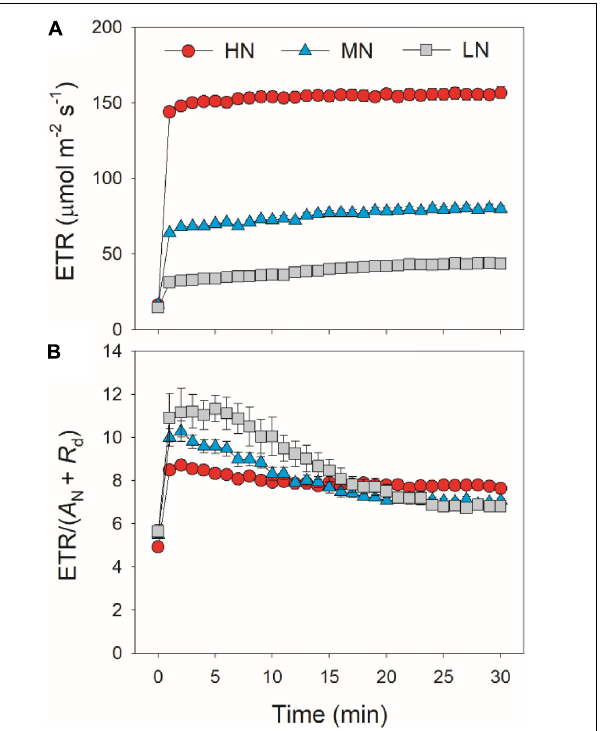
FIGURE 7 | Response of ETR (A) and the ratio of ETR to ( A N + R d ) (B) after transition from 50 to 1,500 µ mol photons m − 2 s − 1 . Values are means ± SE ( n = 5). HN, MN, and LN represent tomato plants grown under high, medium, and low N concentrations,